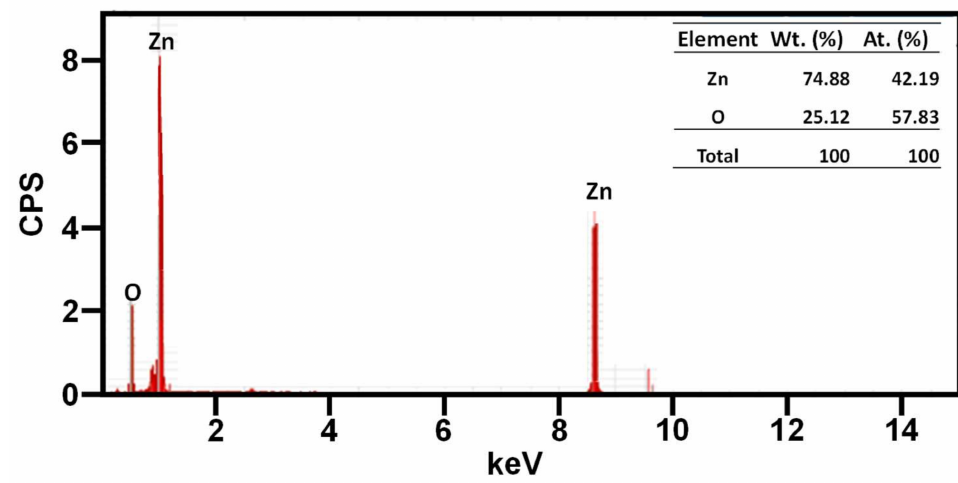
Figure 6. EDX spectrum of synthesized ZnO